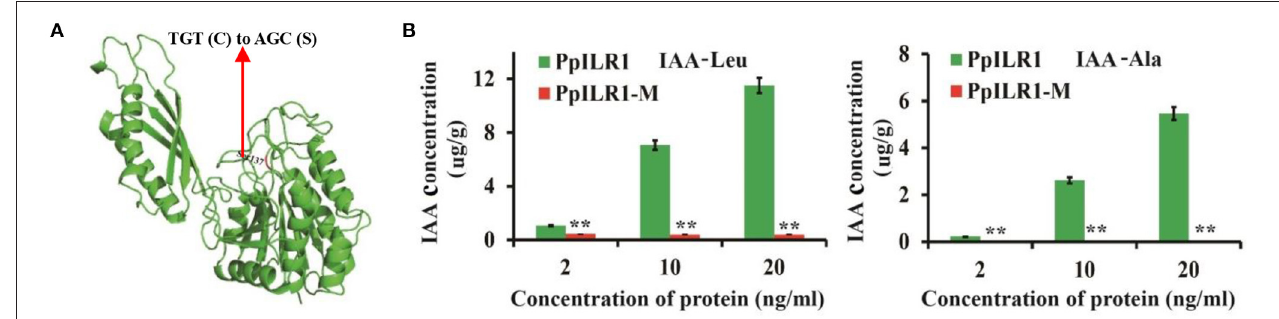
FIGURE 3 | Analysis of the hydrolase activity of the wild-type (WT) protein PpILR1 and the mutant protein PpILR1-M. (A) Mutation site of PpILR1-M. The red arrow indicates the mutation of TGT (Cys137) to AGC (Ser137). (B) Analysis of the hydrolase activity of PpILR1 and PpILR1-M using IAA-Leu and IAA-Ala, respectively, as substrates. Free IAA was used as a standard. Asterisks indicate significant differences between the mutant and WT proteins (** P < 0.01; Student’s t -test).